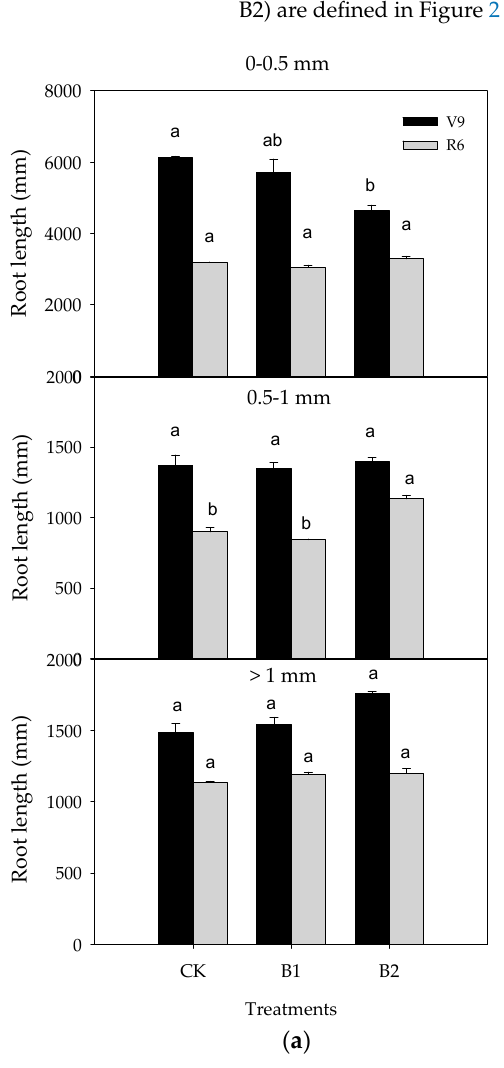
Figure 4. Root lengths of different diameter classes ( a ) and maize grain yield ( b ) under biochar treat ‐ ments. Treatment abbreviations (CK, B1, and B2) are defined in Figure 2 caption. Data are mean ± SE ( n = 3). Different letters above the error bars indicate significant differences between treatment groups at p < 0.05.